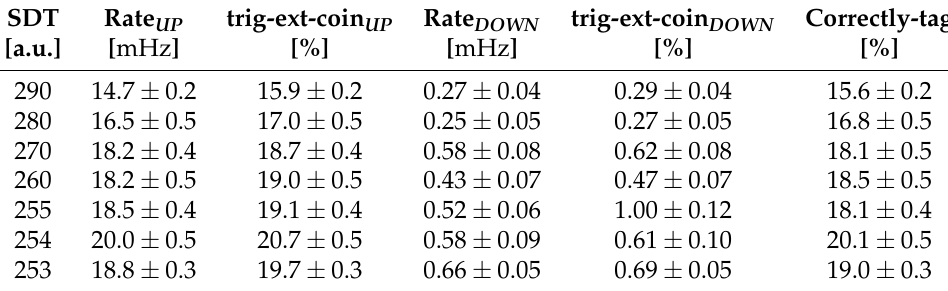
Table 4. As in Table 2, for a charge threshold equal to 70 a.u.